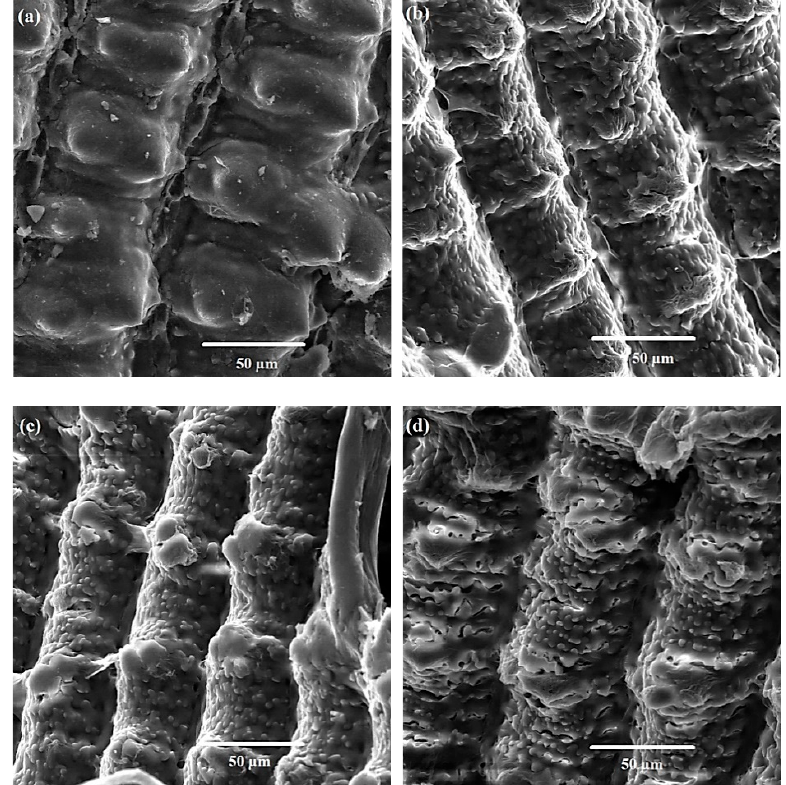
Figure 6. Scanning electron microscope (SEM) images of raw ( a ) and alkaline scoured S10 ( b ), S20 ( c ) and S40 ( d ) rice husk. Table 3. SEM-energy dispersive X-ray spectroscopy (EDX) elemental chemical analysis from the surface of rice